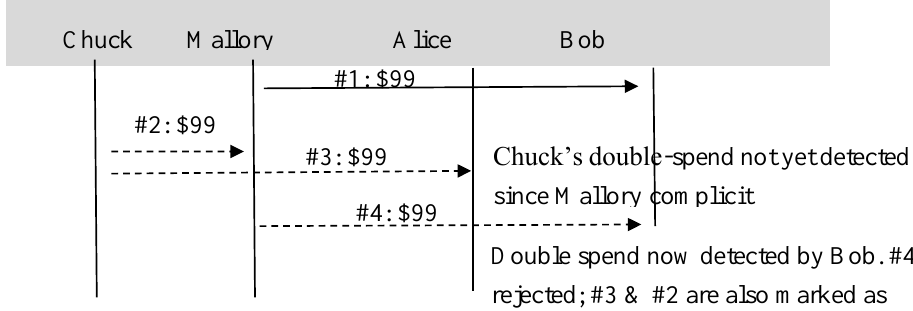
Figure 3. An example of transactions between two dishonest and two honest nodes, including 319 attempted double-spending. 320